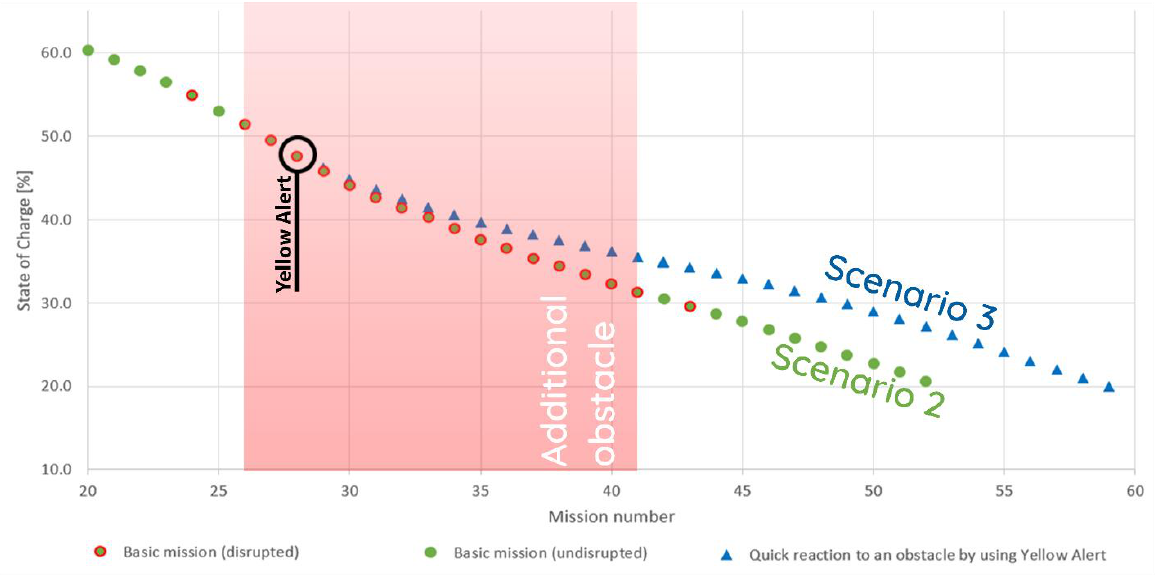
Figure 15. Comparison of energy consumption in experimental scenarios 2 and 3.